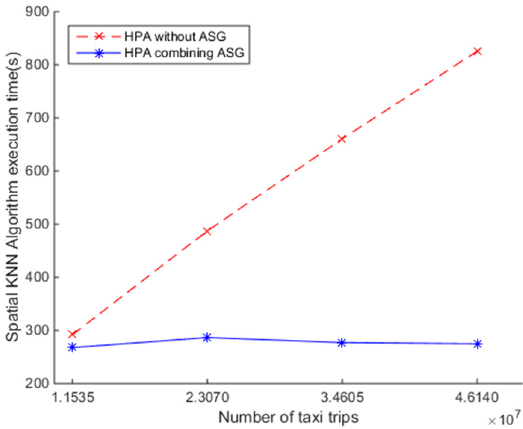
Figure 10. Comparison of the efficiency of SNNQAs using the horizontal pod auto-scaler (HPA) and HPA combined with auto-scaling group (ASG) in OpenStack cloud.